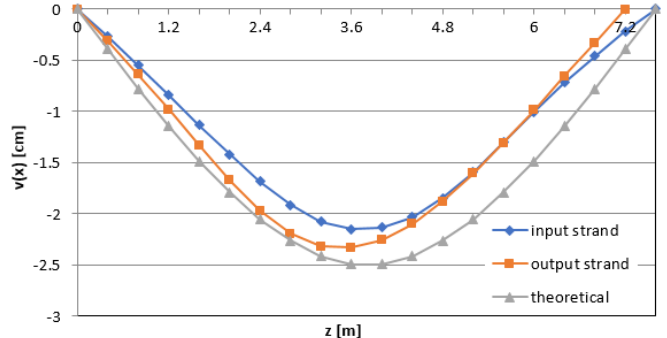
Appl. Sci. 2020 , 10 , x FOR PEER REVIEW Figure 9. Centerline deformation imposed at 2.5 cm. Figure 9. Centerline deformation imposed at 2.5 cm.